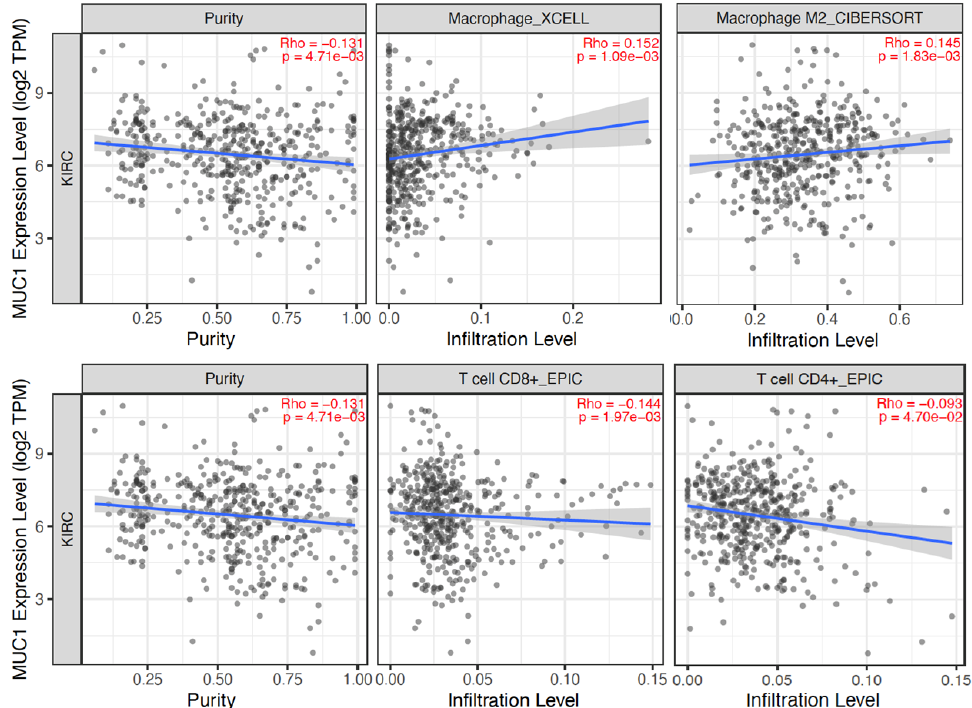
Figure 5. Correlation of MUC1 expression with tumor purity and infiltration level of indicated cell types in ccRCC samples. Data were downloaded from the TIMER web platform. Spearman’s correlation coefficients and p values are shown. TPM: transcript count per million reads.